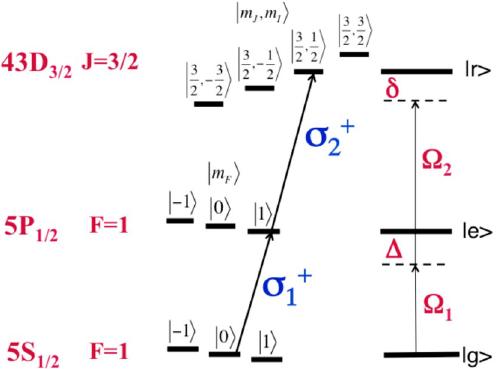
Figure 1. The manifold of magnetic sublevels in an ultracold 87 Rb , relevant for the studies of the electron